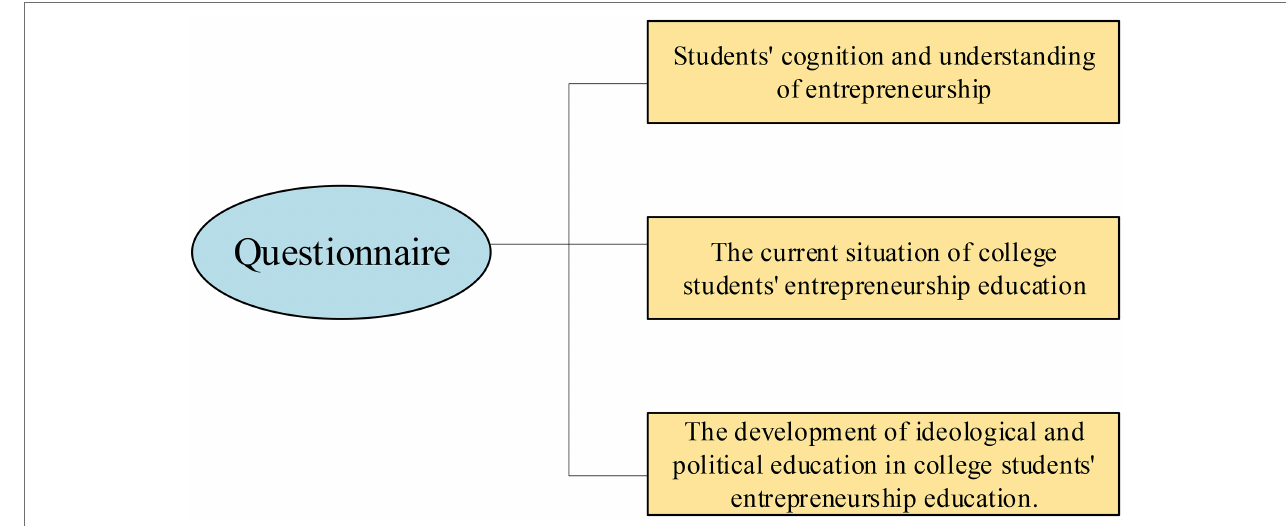
FIGURE 2 | Three parts of the QS.